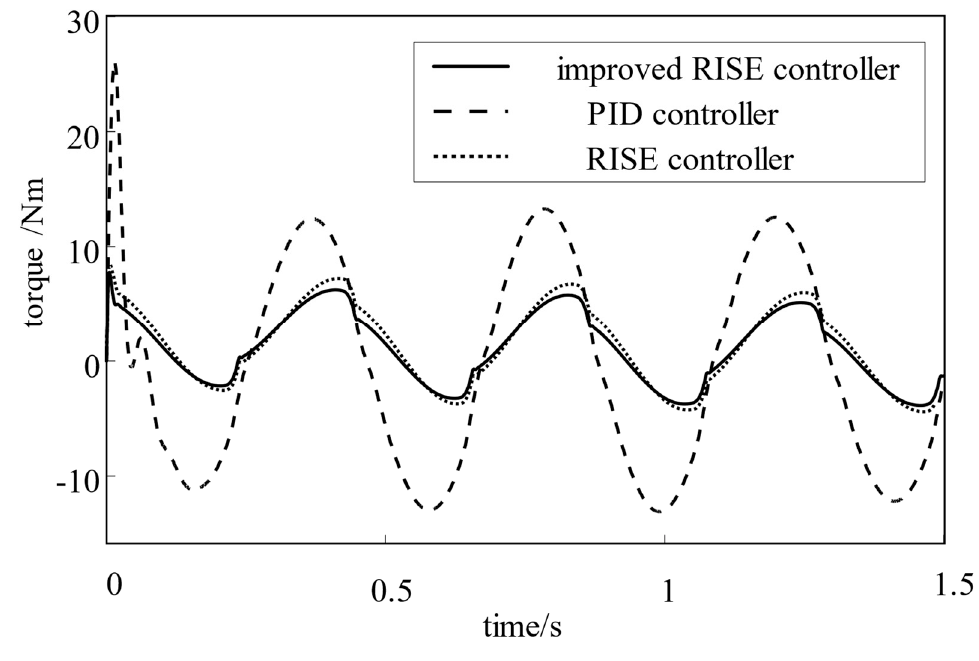
Figure 10. Tracking error of different backlash. Table 2. Tracking error of different backlash.